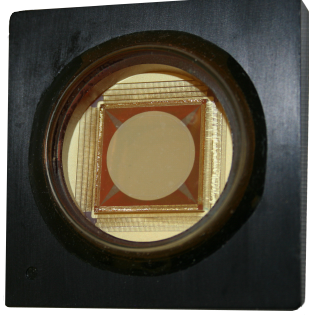
Figure 1. MEMS Deformable Mirror from Boston Micromachines Corporation. The mirror pictured is a KiloDM with 952 actuators across the 1 cm-wide